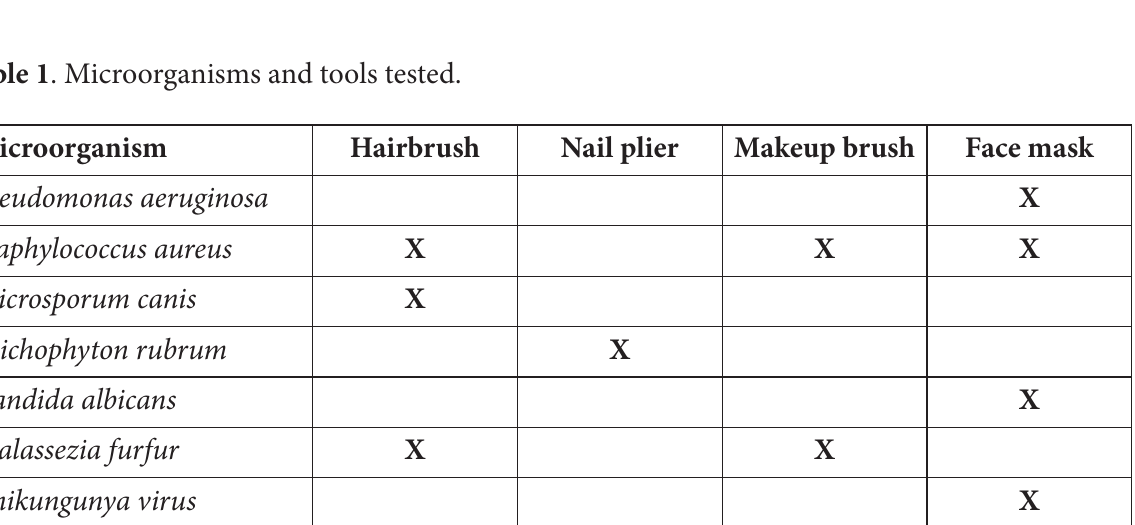
Figure 1 . (A) Asepsis Kit, release 1.1 (courtesy of BR LABS Tecnologia Óptica e Fotônica Ltda); (B) lamp spectrum in the UV-C region.